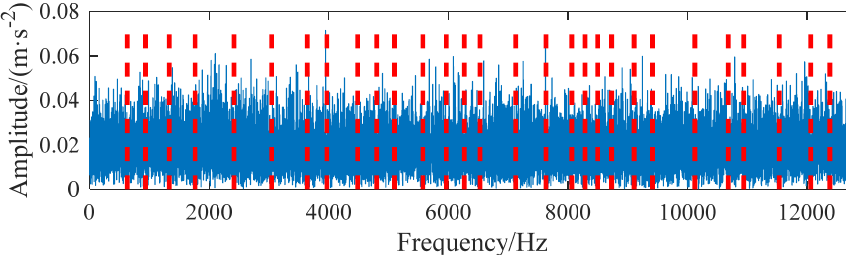
Figure 5. Adaptive spectrum segmentation.